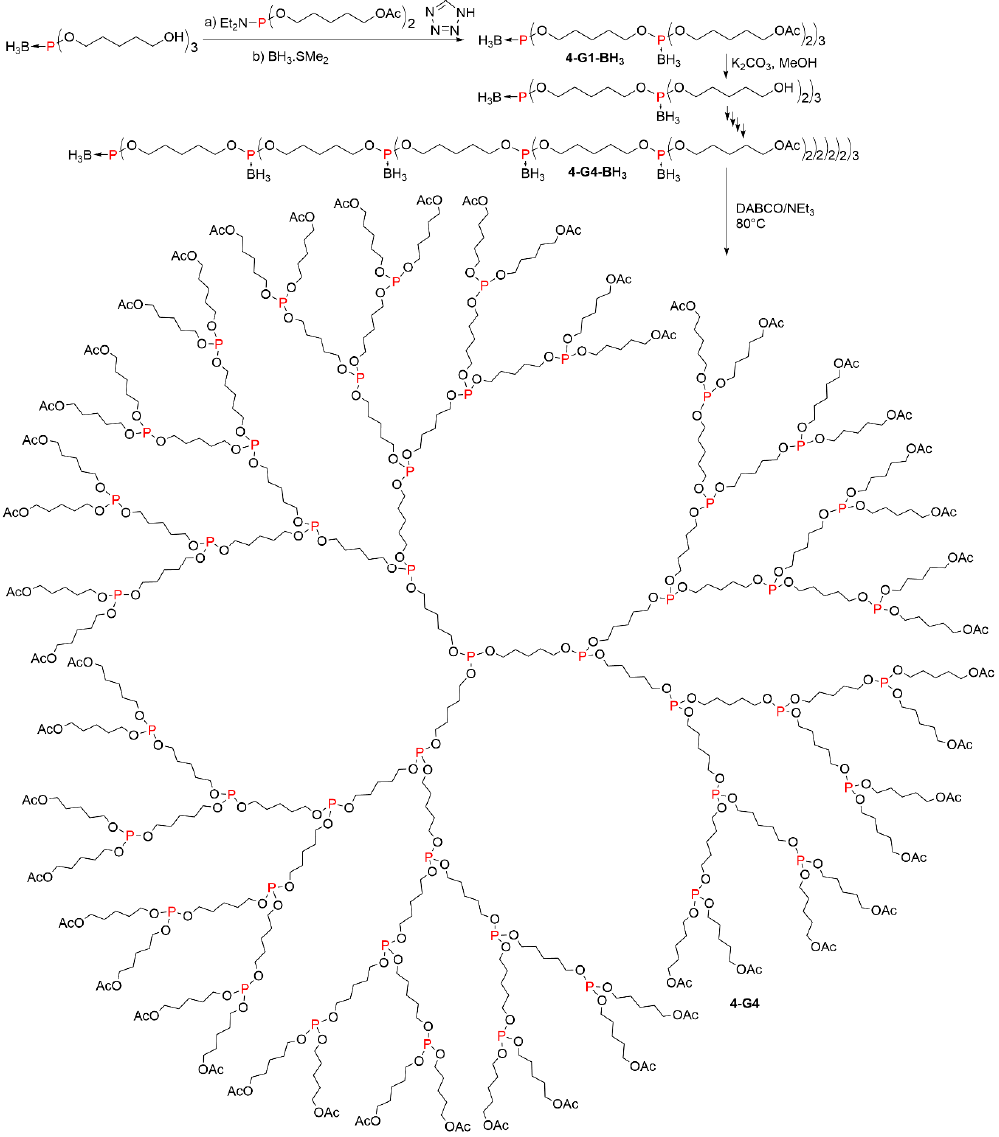
Scheme 4. Synthesis of boranophosphate triesters and phosphite-based